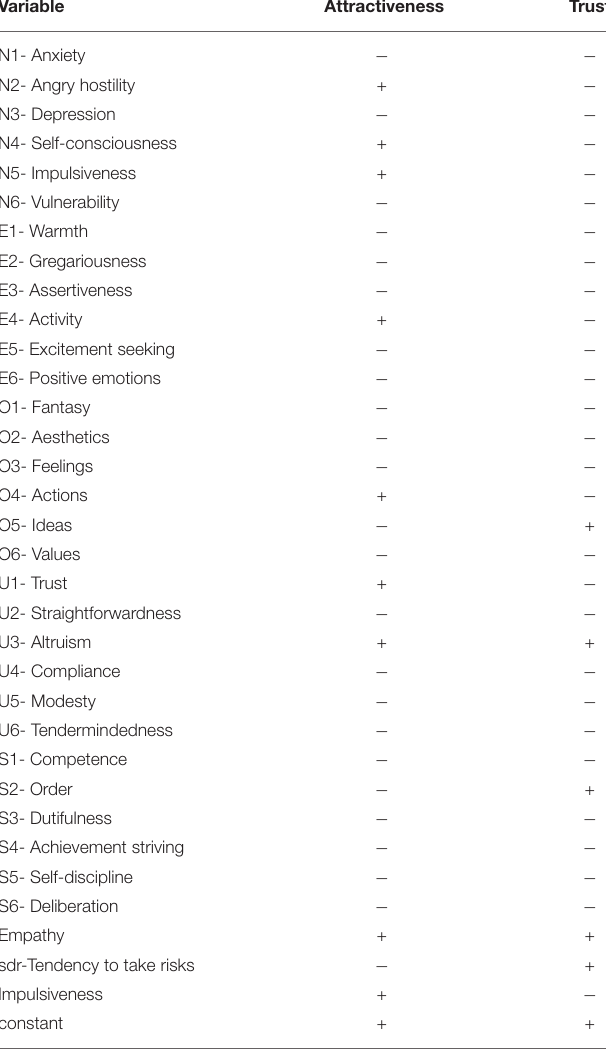
TABLE 1 | Summary of the most important explanatory variables (marked with a “+” in the table) for the variables attractiveness and trust, which remained after elimination by backward logistic stepwise regression based on the Wald coefficient.